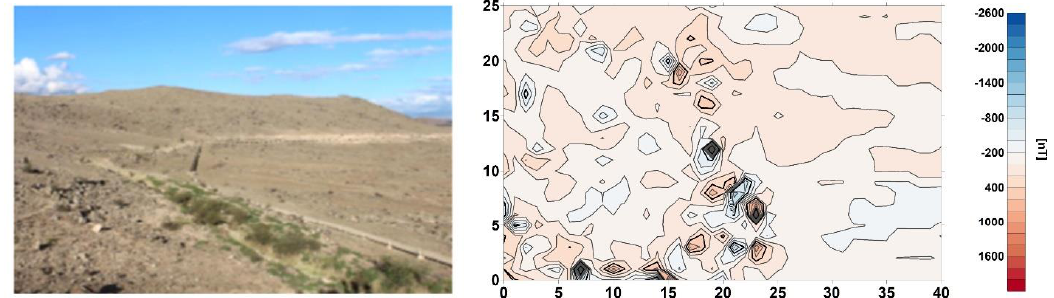
Figure 29. Depiction of magnetic gradients registered at the Lernamerdz archaeological site.